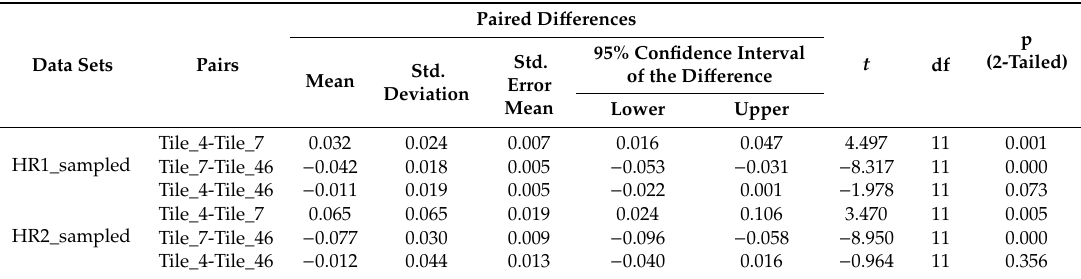
Table 4. Results of paired t -test for comparing the P content (mg / kg) in the hybrid resins deployed in three tile lines. The data are shown in Figure 5.